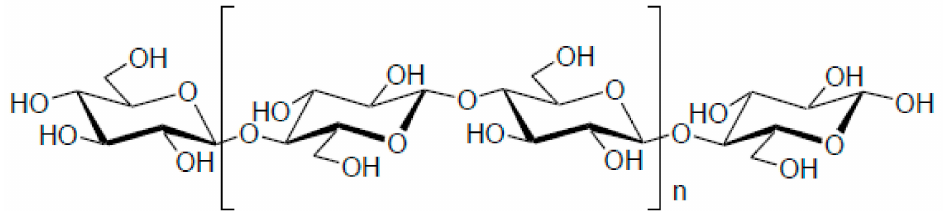
Figure 1. Structure of cellulose.